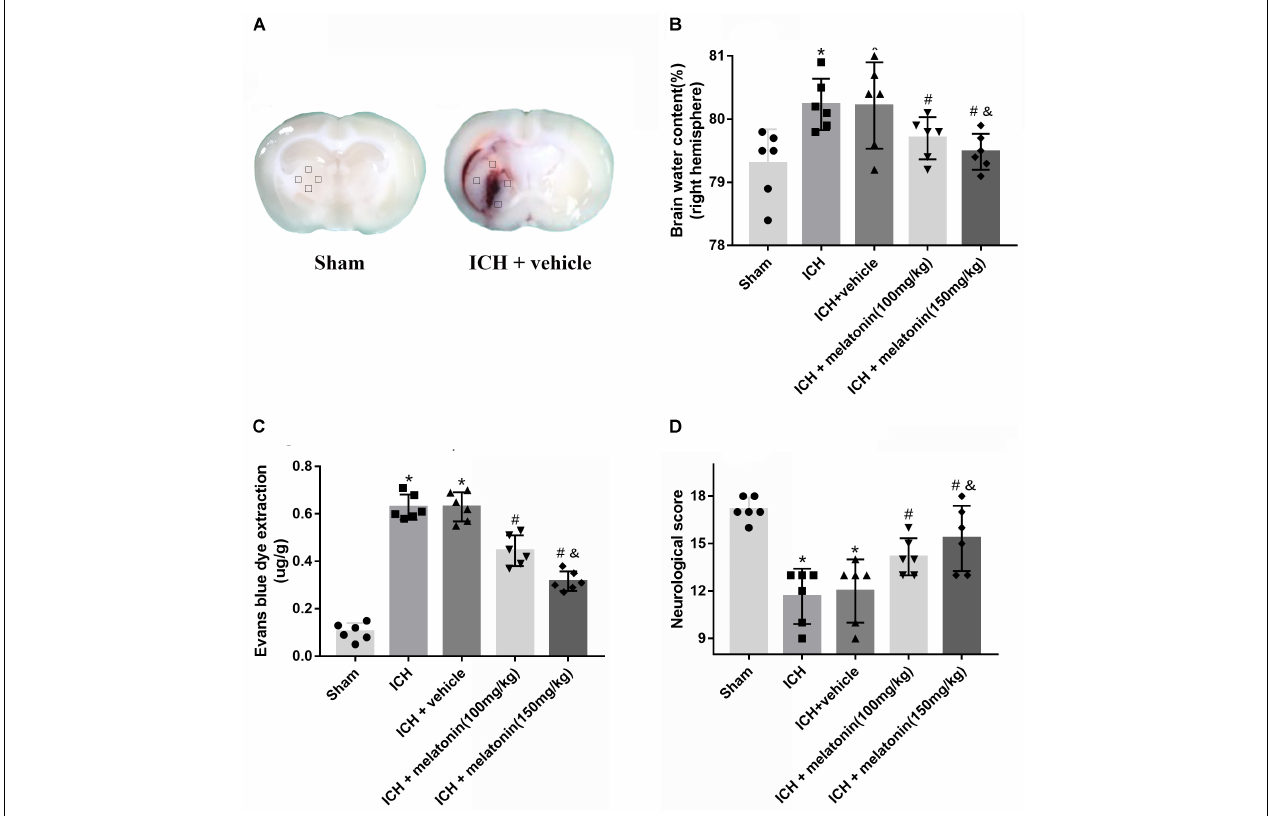
FIGURE 2 | Effects of melatonin on neurological functions, brain edema and BBB leakage. (A) Representative pictures of brain slices in sham and ICH group (24 h); (B) the quantification of brain water content at 24 h after ICH; (C) the quantification of Evans blue dye extravasation at 24 h after ICH ( n = 6 for each group); (D) . The quantification of neurological functions; The bars represent the mean ± SD. ∗ p < 0.05 vs. sham, # p < 0.05 vs. ICH at 24 h, & p < 0.05 vs. ICH + melatonin (100 mg/kg).